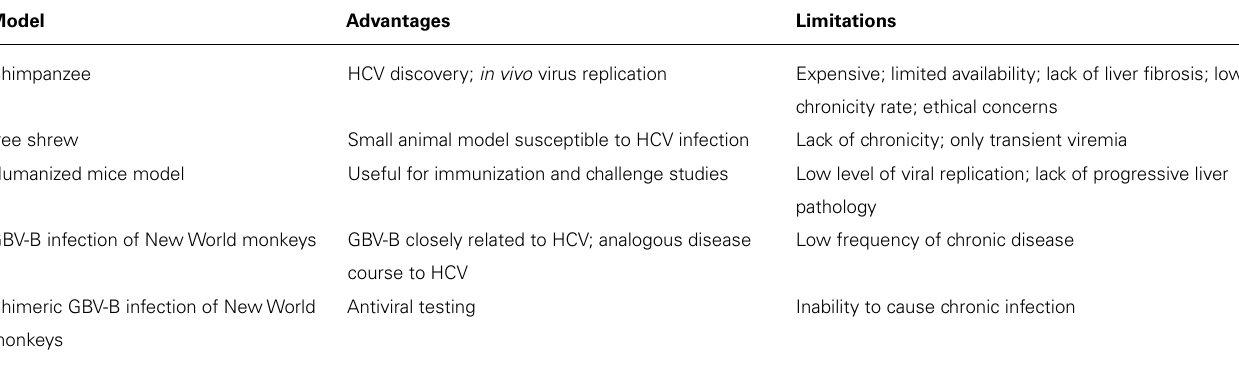
Table 3 |Animal models for